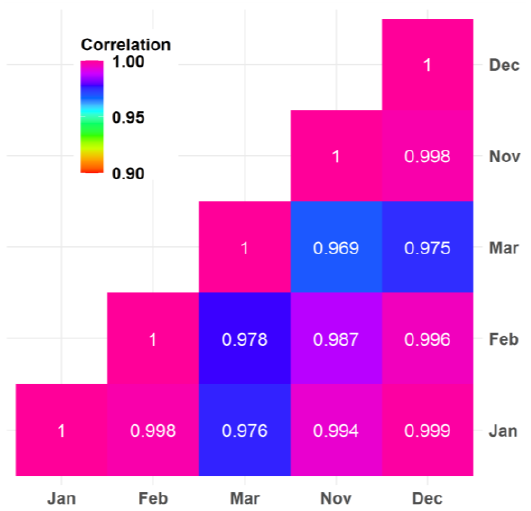
Figure 15. Correlation coefficient of monthly heating energy.